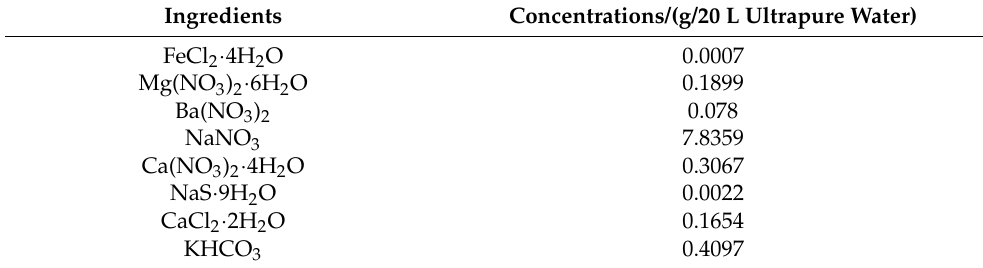
Figure 1. ( a ) Bimetallic pipe; ( b ) 316L specimen used in corrosion experiment. Table 1. Formula for the simulated liquid used in high temperature and high pressure immersion experiment.